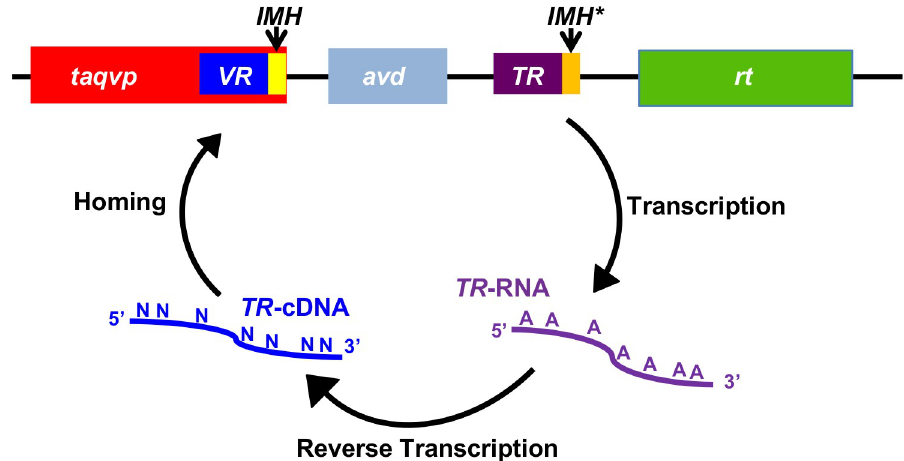
Fig 1. T . aquaticus DGR. The T . aquaticus prophage DGR contains a gene encoding a variable protein ( taqvp ). The 3’ end of taqvp contains the variable region ( VR ) and initiation-of-mutagenic homing (IMH) sequence. The DGR also contains an accessory variability determinant ( avd ) gene, followed by an invariant template region ( TR ), which differs from VR mainly at adenines. A sequence similar but not identical to the VR IMH occurs at the 3’ end of the TR and is called IMH � . Following these elements is a gene encoding a reverse transcriptase ( rt ). TR is transcribed to produce TR - RNA, which is reverse transcribed to produce TR -cDNA, with adenine-specific mutagenesis of the sequence accompanying reverse transcription. Adenine-mutagenized TR -cDNA homes to and replaces VR to yield a variant TaqVP. Three fundamental components define DGRs: a reverse transcriptase (RT) that has a unique sequence motif [1, 2, 18], a variable region ( VR ) that forms part of the coding sequence of a DGR diversified protein, and a template region ( TR ) that is nearly identical to VR and is located proximally to VR (Fig 1). The TR serves as an invariant store of amino acid coding information. This information is transferred from TR to VR , and during this process adenines within TR are specifically mutated to other bases. A recent study on the prototypical DGR of Bordetella bacteriophage indicates that the DGR RT in association with a second DGR protein, the accessory variability determinant (Avd), is necessary and sufficient for mutagenesis of ade- nines in TR [19]. Adenine-specific mutagenesis culminates in substitutions occurring only at amino acids that have adenines in their codons in TR . AAY is the most recurrent adenine-con- taining codon in the TR of a variety of DGRs [2]. As previously noted, adenine-mutagenesis of Asn-encoding AAY can result in the encoding of 14 other amino acids, which cover the gamut of amino acid chemical character, but cannot result in a stop codon [20]. DGR variable proteins are divergent in sequence (roughly � 20% identity) [2, 20]. To date, structures of three DGR variable proteins have been determined— Bordetella bacteriophage Mtd [20, 21], Treponema denticola TvpA [3], and Nanoarchaeota AvpA [22]. Despite the sequence divergence of these proteins, they all share a C-type lectin (CLec)-fold, which appears to be an evolutionarily conserved scaffold among DGRs for accommodating massive protein sequence variation. The CLec-fold, despite its nomenclature, is a general ligand-binding fold [23]. Variable amino acids in these CLec-fold DGR variable proteins are solvent-exposed and form ligand-binding sites. Some DGR variable proteins, including those that exist in the human virome [6], are predicted instead to have an immunoglobulin (Ig)-fold as a scaffold for variation. The β -strand body of the Ig-fold appears to be the locus for variation in these pro- teins, rather than loop regions as in antibodies and T cell receptors. Yet other DGR variable proteins have folds that at present cannot be assigned by sequence alone to CLec- or Ig-folds, or to other protein folds [2].